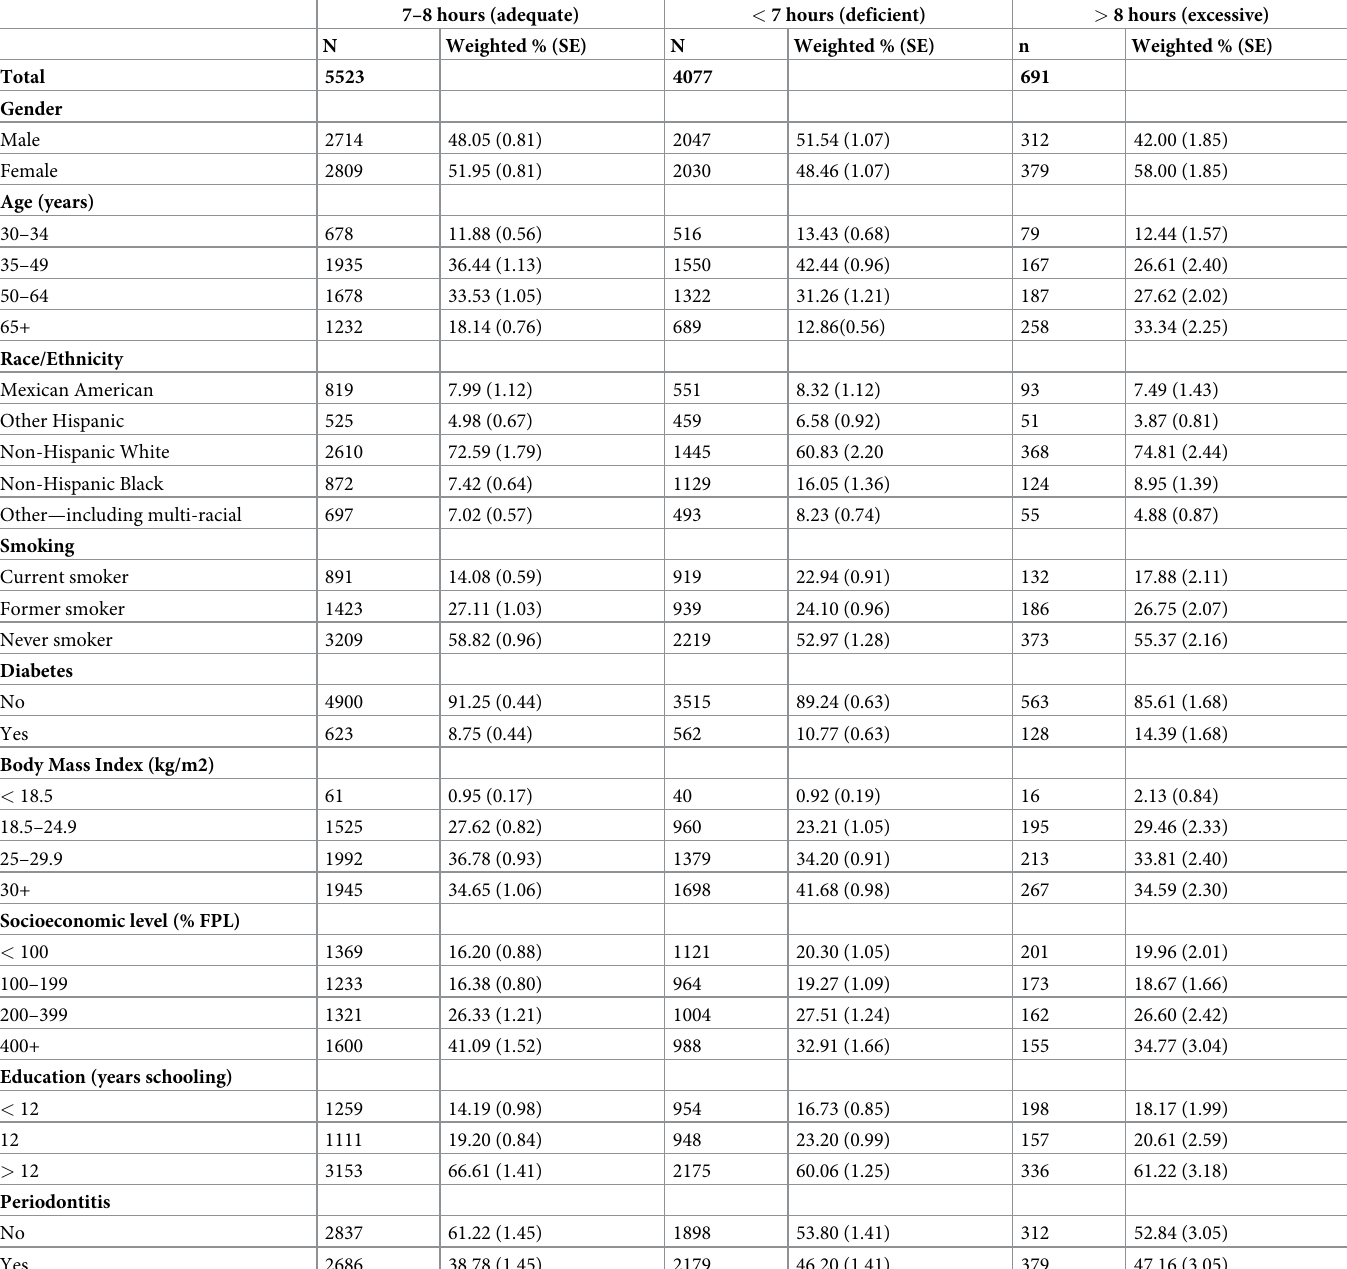
Table 1. Characteristics of the study population by sleep duration